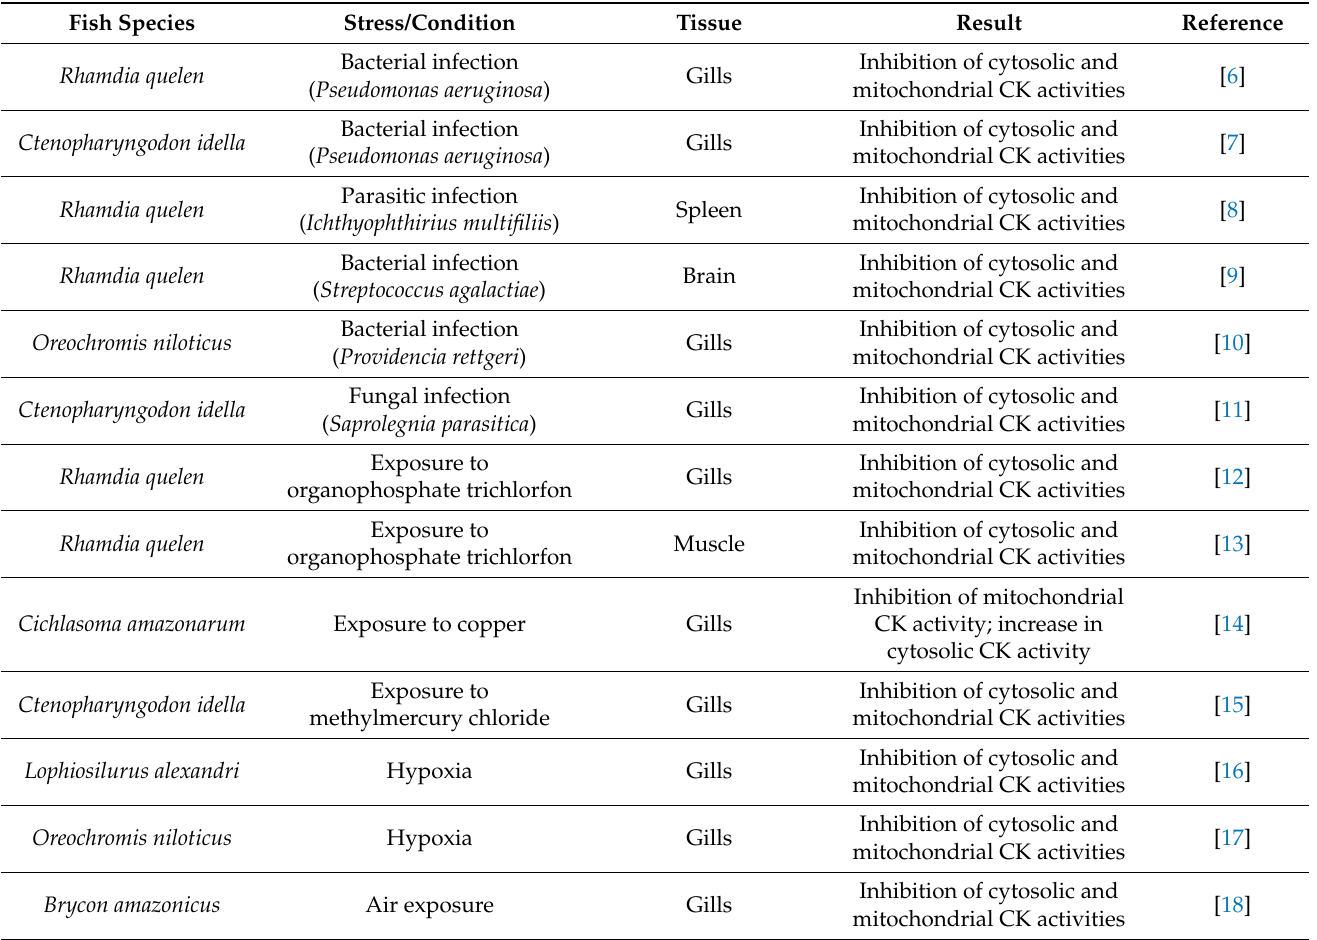
Table 1. The use of creatine kinase (CK) activity as an indicator of impairment in energetic homeostasis in fish submitted to several